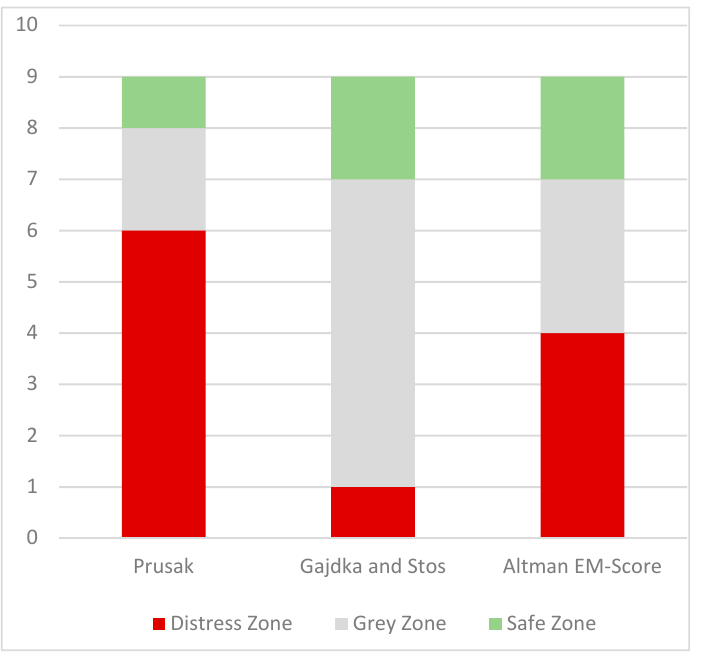
Figure 1. The classification of companies according to the discriminant models in the first half of 2019.